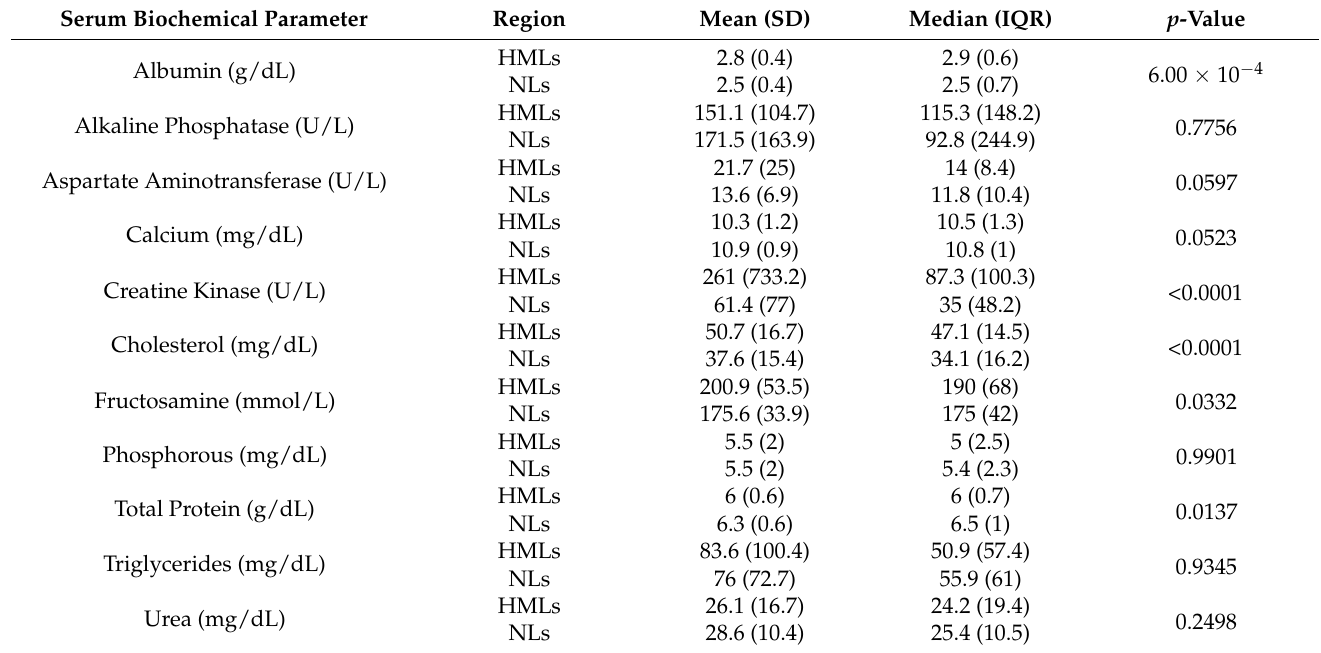
Table 5. Comparisons of biochemical parameters between capybaras from human-modified landscapes (HMLs) and natural landscapes